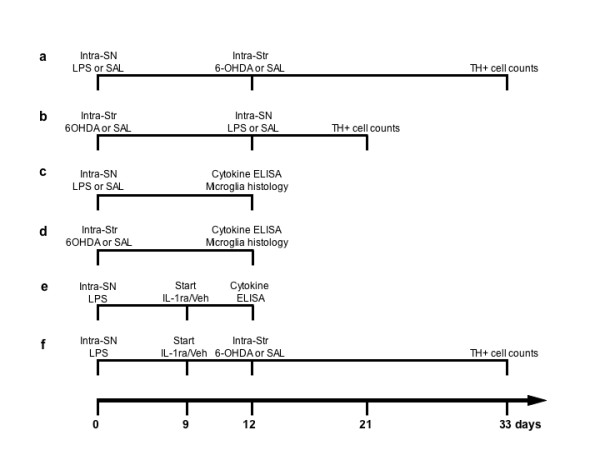
Experimental timelines. Each timeline represents in vivo experimental procedures and postmortem analyses conducted. Number of animals in each group: (A) n = 6, (B) n = 6, (C) n = 7, (D) n = 7, (E) n = 5, (F) n = 8. LPS, lipopolysaccharide; 6-OHDA, 6-hydroxydopamine, SAL, saline; IL-1ra, interluekin-1 receptor antagonist; veh, vehicle; SN, substantia nigra, Str, striatum.